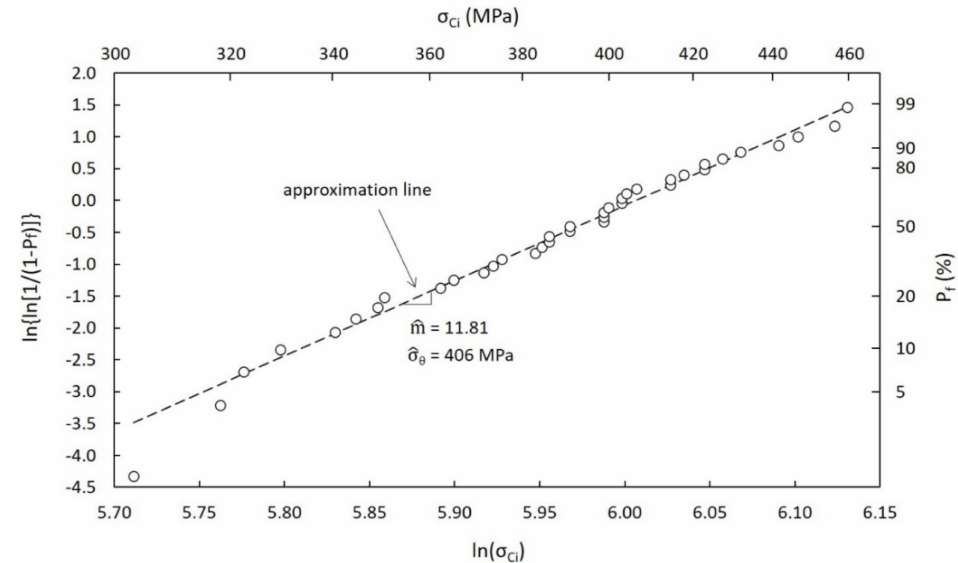
Figure 14. Weibull plot of strength data for SiC SA (RTPs approach).